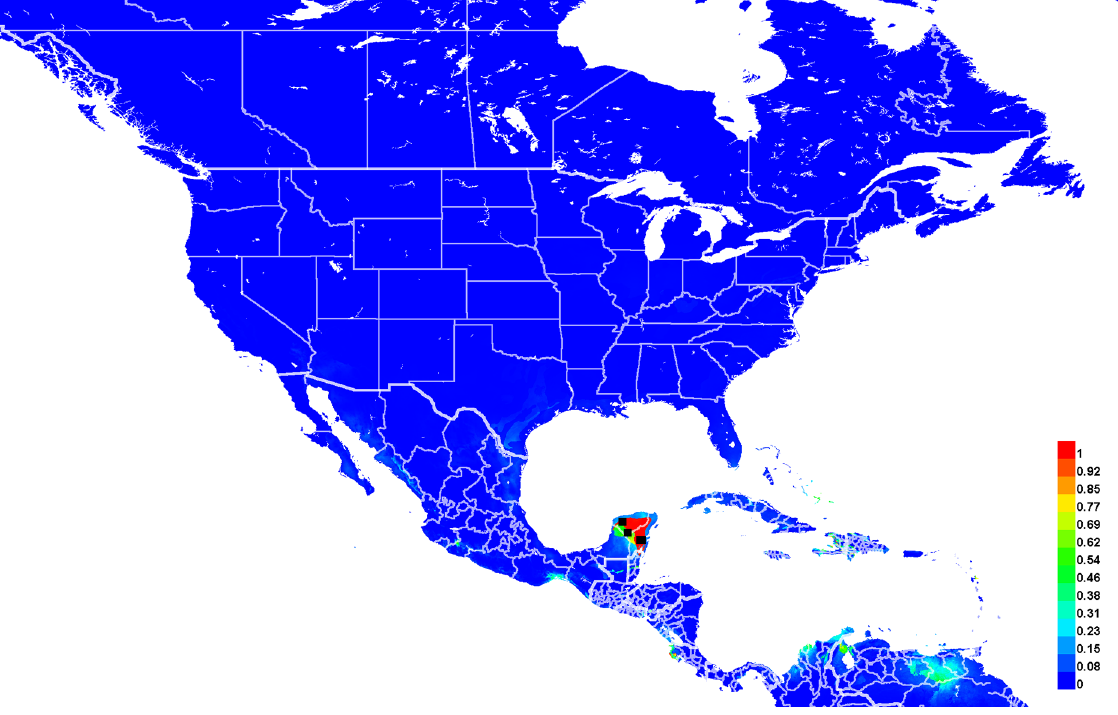
Fig. 60. Georeferenced collection records of Lasioglossum ( D. ) meteorum sp. nov. (black squares) and predicted distribution by maximum entropy ecological niche modeling in Maxent (colour shading). Warmer colours indicate higher cloglog probability of